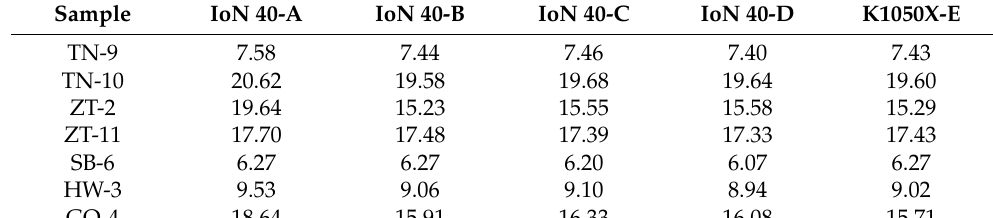
Table 5. The LTAs yield (%) of coal samples obtained by the different programs of two ashers. Sample